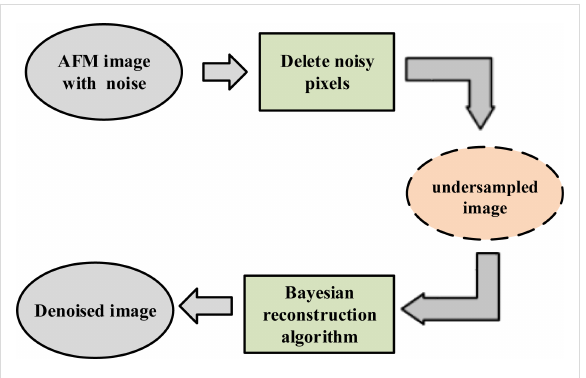
Figure 1: The schematic of removing impulse noise from AFM images based on Bayesian compressed